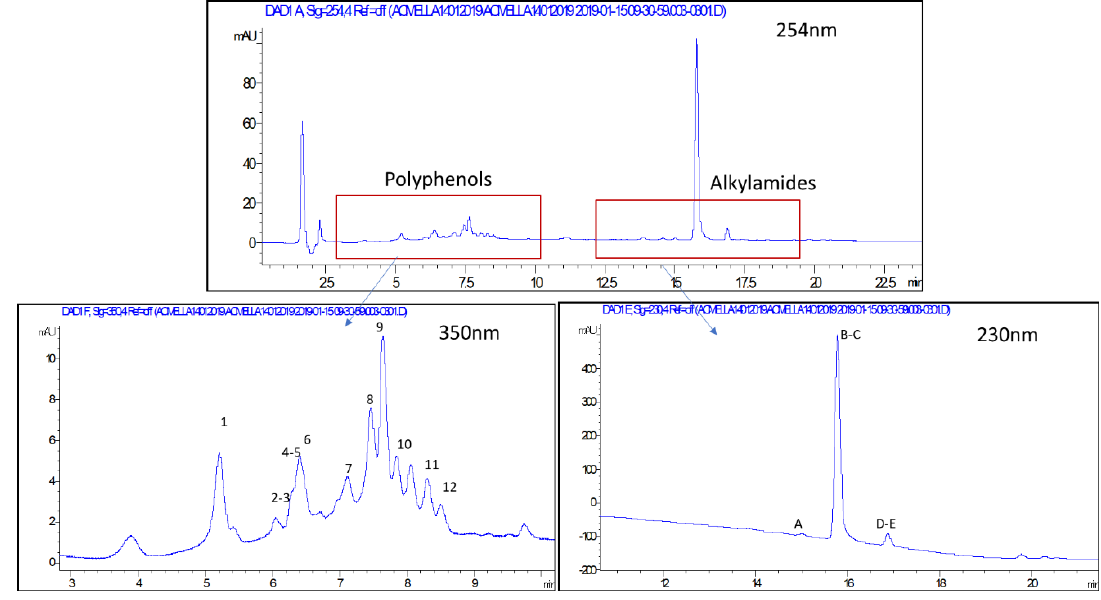
Figure 5. Chromatogram of A. oleracea extract at 254 nm and enlargements at 350 nm of polyphenol signals and at 230 nm of alkylamide signals .